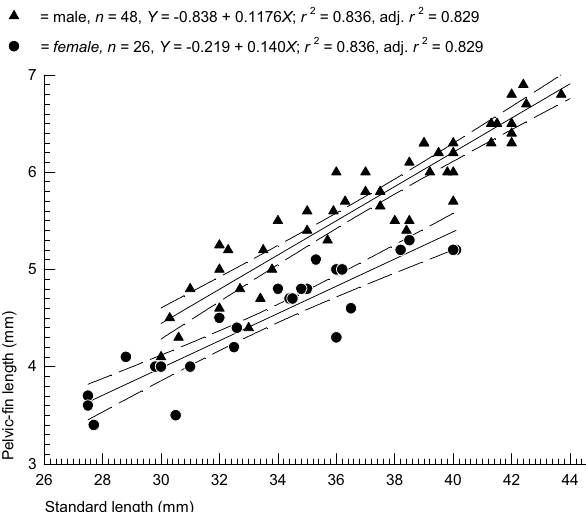
Fig. 10. Pelvic fin length as a function of SL by sex for males = (cid:83) and females = (cid:122) of Bryconadenos tanaothoros . For explanation see text under sexual